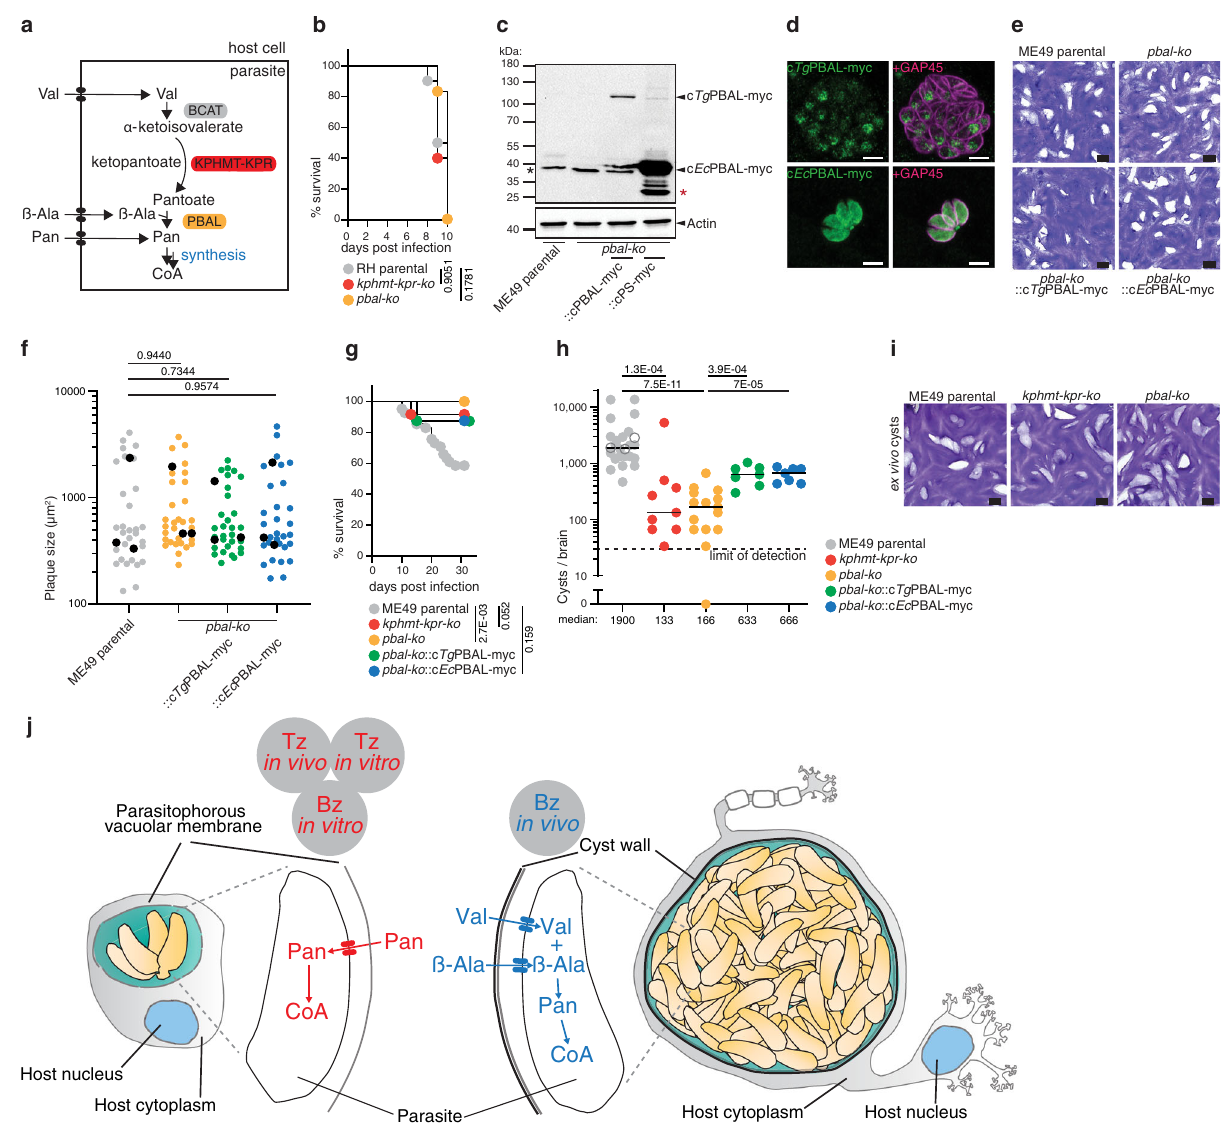
Fig. 8 Pantothenate synthesis is essential for chronic infection of T. gondii in vivo. a Scheme of the Pan biosynthesis pathway, highlighting the ketopantoate hydroxymethyl transferase - ketopantoate reductase (KPHMT-KPR) and the pantoate beta alanine ligase (PBAL). See Fig. 1 for abbreviations. b Survival curve of mice infected with RH parental ( n = 10), kphmt-kpr-ko ( n = 5) and pbal-ko ( n = 5) parasites (from 2 experiments, logrank Mantel – Cox test). c Western blot of complementant strains pbal-ko ::c Tg PBAL-myc ( n = 3) and pbal-ko ::c Ec PBAL-myc ( n = 4). Antibodies anti myc, anti actin as loading control. d IFA of pbal-ko ::c Tg PBAL-myc ( n = 5) and pbal-ko ::c Ec PBAL-myc ( n = 3). Antibodies anti myc, anti GAP45 as marker of parasite pellicle. e Plaque values of independent experiments ( n = 3). g Survival curves of mice infected with ME49 parental ( n = 41, 24 survived), ME49 kphmt-kpr-ko ( n = 12, pooled from 5 independent experiments. h Ex vivo cyst count from mouse brains infected for 5 weeks with parental ME49, kphmt-kpr-ko , pbal-ko , pbal- counts before the 5 weeks endpoint. Median is represented, 2-sided Mann – Whitney test. i Representative plaque assay of brain-derived cysts from ME49 parental, kphmt-kpr-ko and pbal-ko infected mice ( n = 3, 3, 4, respectively). j Cartoon schematic depicting the different modes of Pan acquisition in tachyzoites (Tz) and bradyzoites (Bz). n number of independent biological replicates. Source data are provided as a Source Data fi le. White scale bar 5 µ m. Black scale bar 1 mm. Red asterisk marks degradation product of tagged protein. Black asterisk marks unspeci fi c